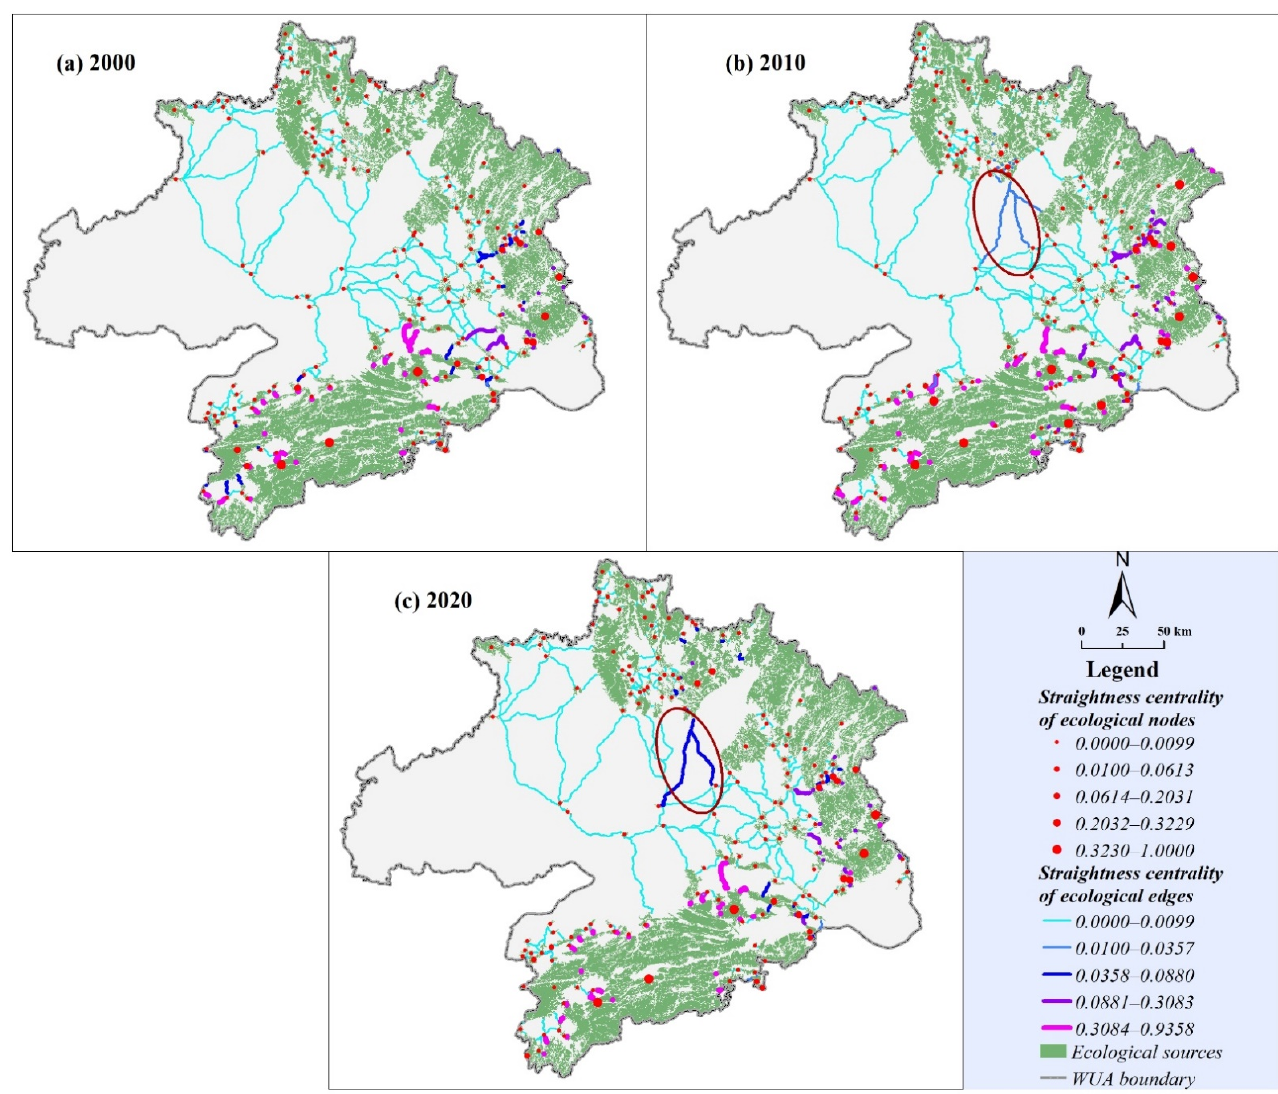
Figure 10. Spatial distribution of straightness centrality in 2000, 2010, and 2020.